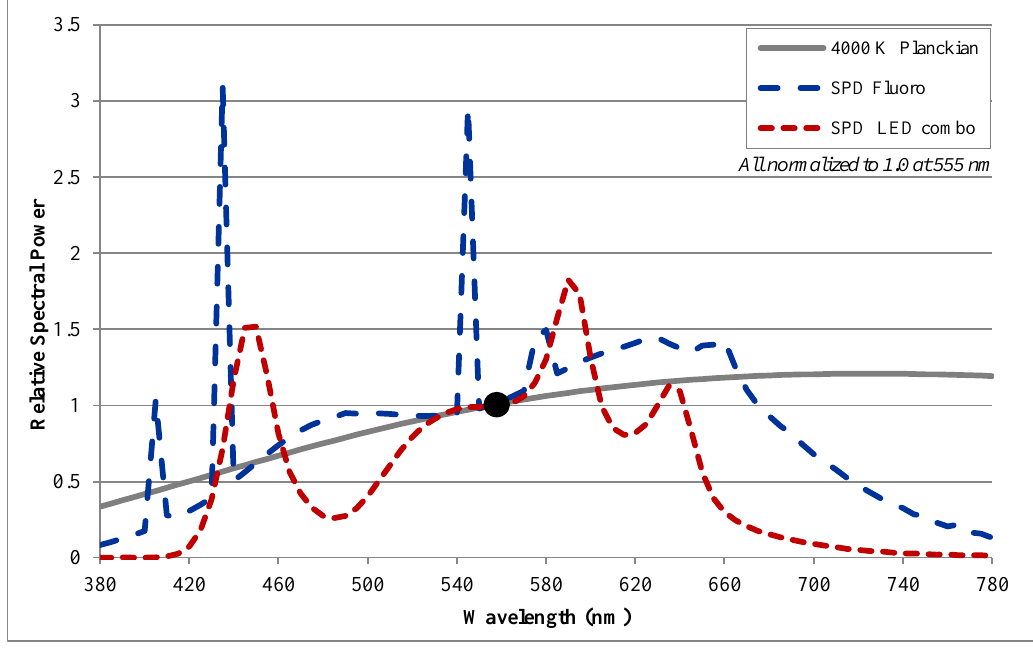
Figure 4. SPDs of the two 4000 K test sources discussed previously, together with the 4000 K Planckian reference to illustrate the spectral similarity approach